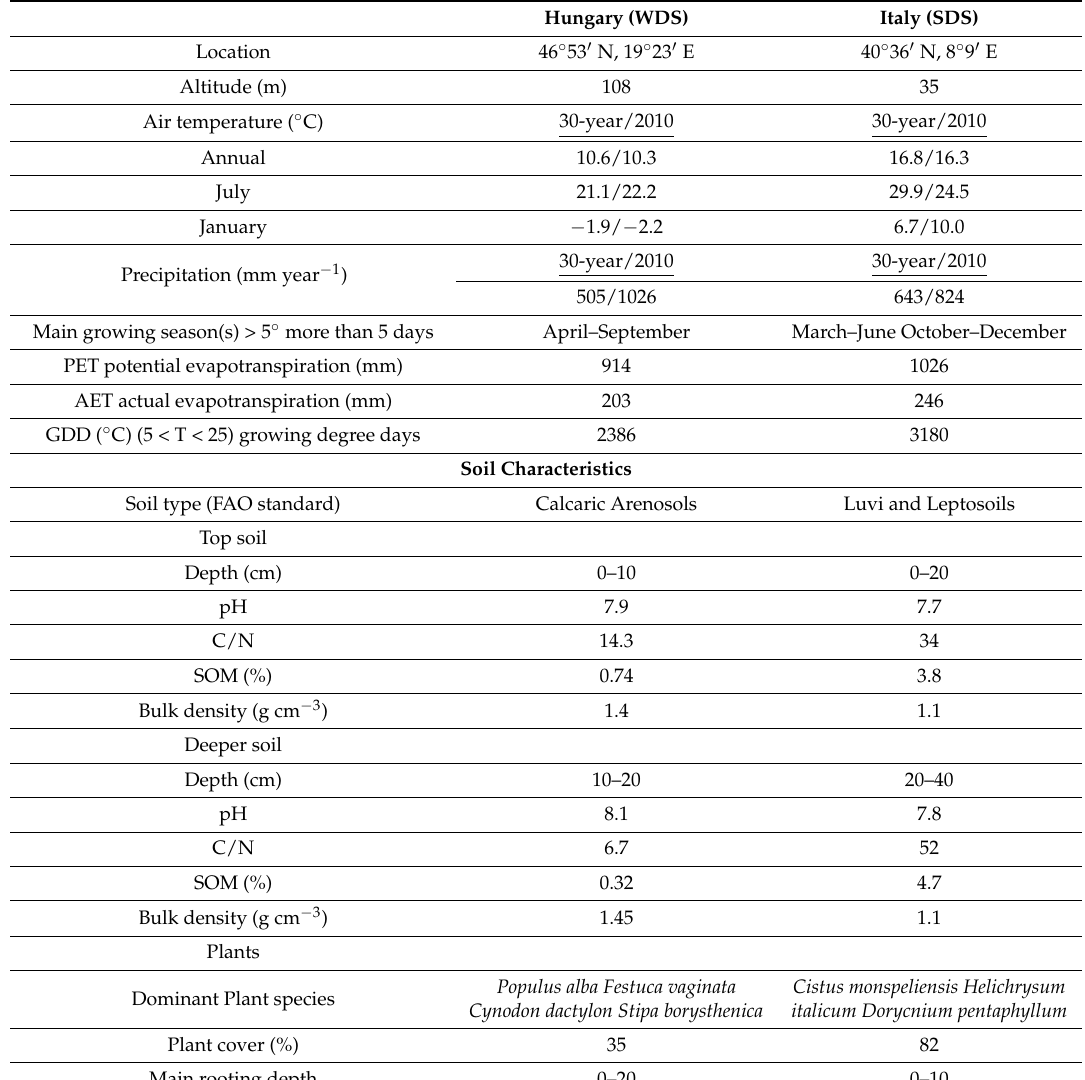
Table 1. Main characteristics of the study areas. The two values of air temperature and precipitation refer to the 30-year average measured in a proximal meteorological station and to the 2010 values measured at the study